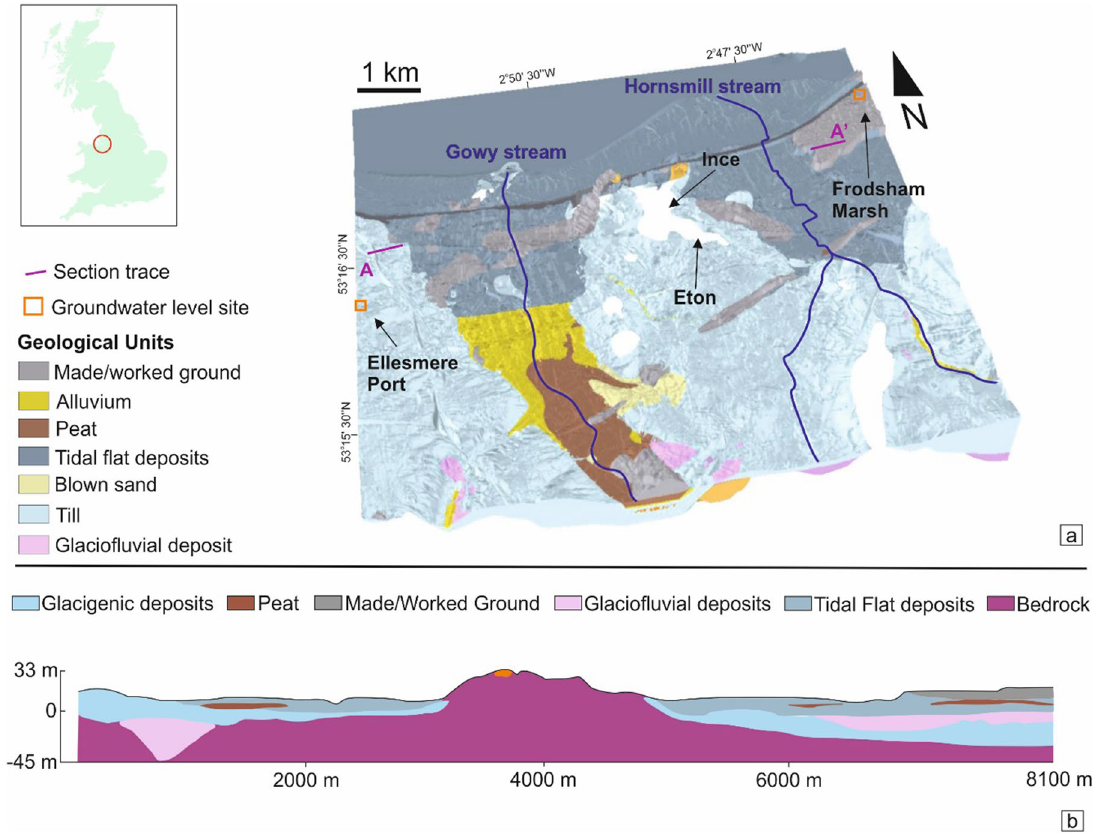
Figure 1. Location and geological setting of the area under consideration for the location of the Cheshire Observatory. ( a ) Location of the study area within the Great Britain and 3D superficial model of the area of interest 10 with all geological units shown and location of the groundwater level site measurements from the Environment Agency. Vertical exaggeration 20:1. ( b ) WSW-ENE geological cross section for superficial deposits derived from the 3D geological model; vertical exaggeration 10:1. White areas indicate where these units are absent. Includes Ordnance Survey data, Crown copyright and database rights [2016] Ordnance Survey [100021290 EUL] and British Geological Survey materials, UKRI